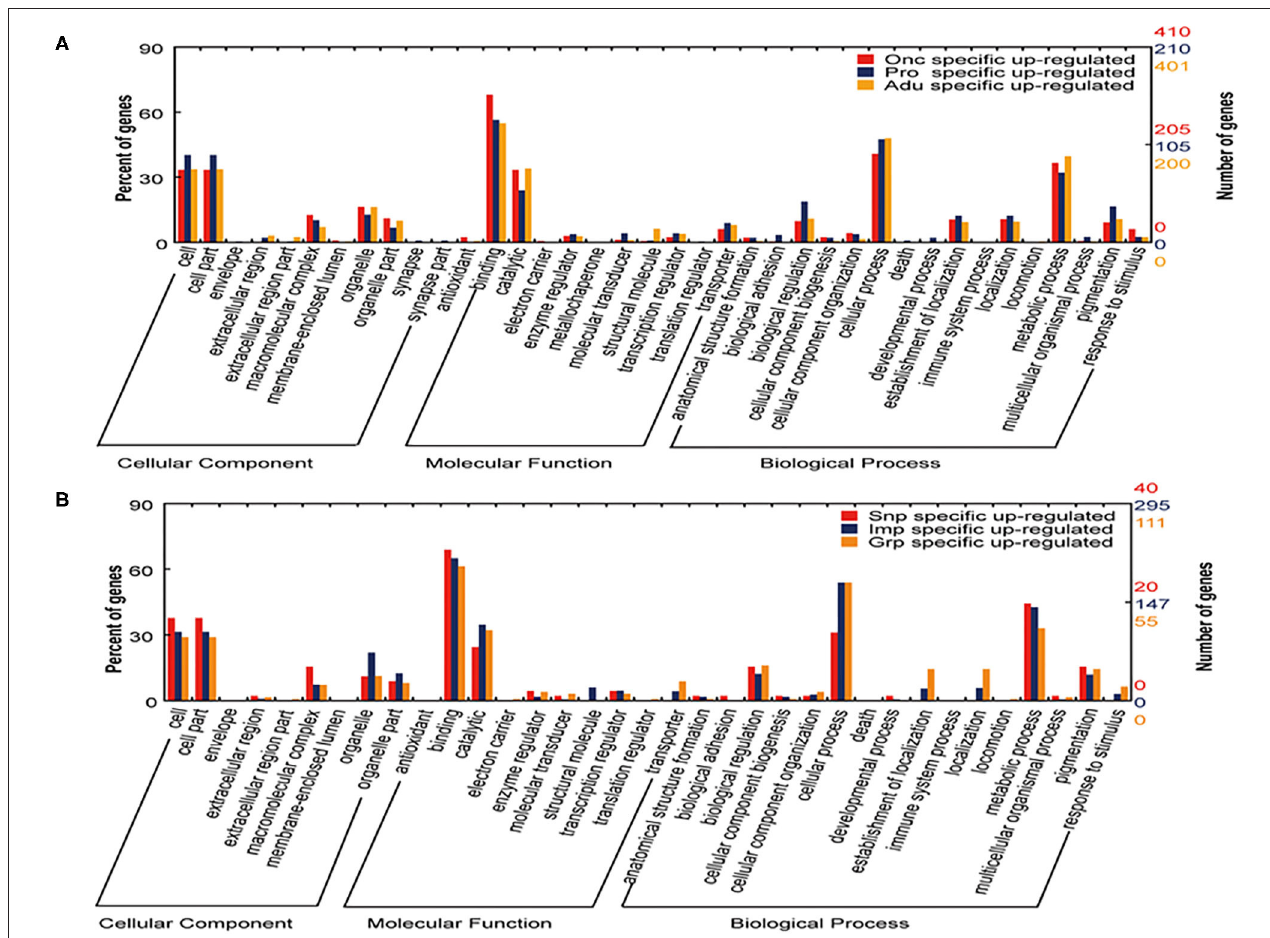
FIGURE 3 | GO analysis of the specific genes upregulated in different developmental stages and tissues of T. multiceps. (A) Functional classification of specific upregulated genes in three stages (Onc, Pro, and Adu) of T. multiceps . (B) Functional classification of specific upregulated genes in three tissues of adult T. multiceps